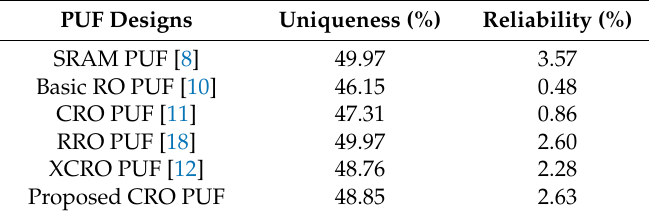
Table 2. Average uniqueness and reliability of different types of PUF implemented in